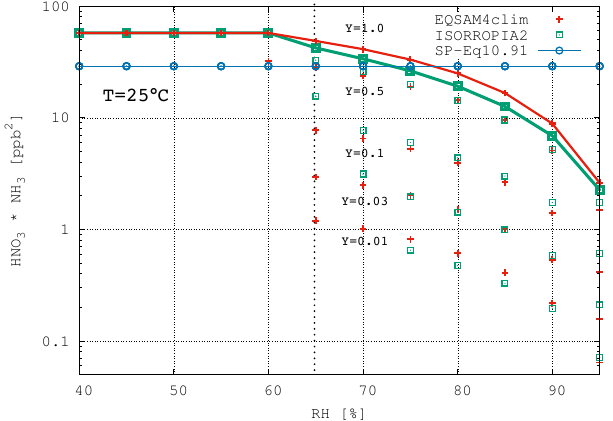
Figure 2. NH 4 NO 3 equilibrium dissociation constant as function of RH (at T = 298 . 15 [ K ] ) for various ionic strength factors (Y) defined in Seinfeld and Pandis (2006); see their Fig. 10.21. Red crosses show the results of EQSAM4clim, green squares those of ISORROPIA II. The line points refer to pure ammonium nitrate (Y = 1 ) . The vertical line at RH = 65 [ % ] indicates the solid–liquid phase partitioning threshold for the mixed solution, shown in Se- infeld and Pandis (2006). The ordinate values refer to the prod- uct of [ NH 3 ] (g,AN) ×[ HNO 3 ] (g,AN) that are obtained at end of the gas–liquid–solid NH 4 NO 3 partitioning of ISORROPIA II, and by Eq. (9) for